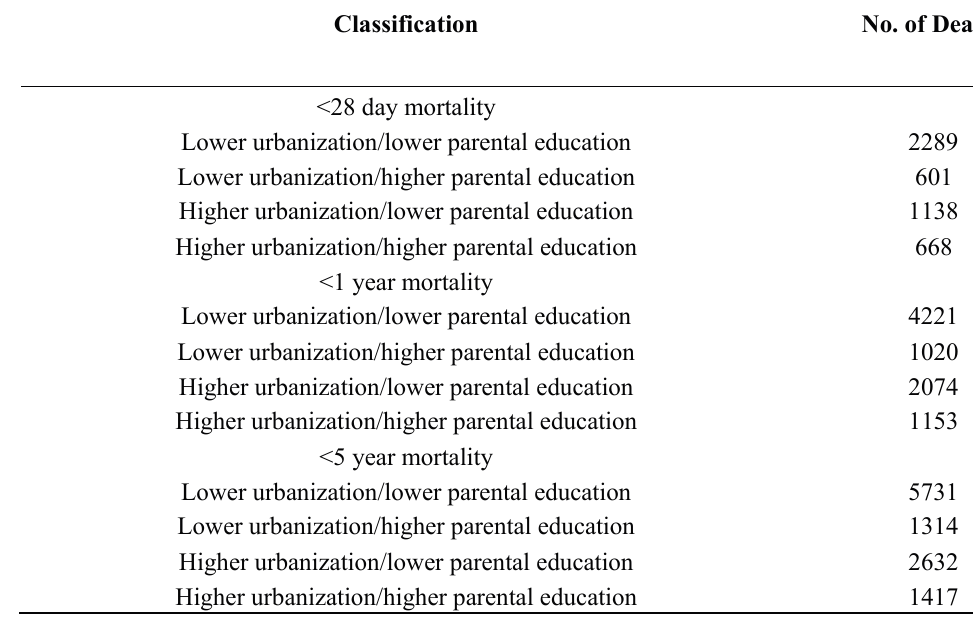
Unadjusted Estimates Adjusted Estimates a OR 95% CI OR 95%